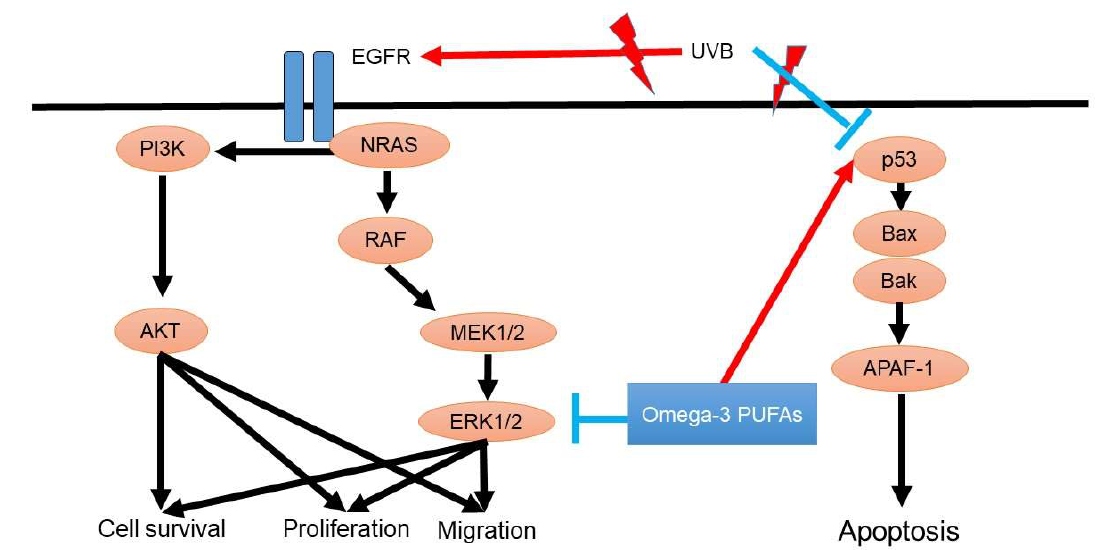
Figure 3. Oncogenesis signaling of squamous cell carcinoma and possible roles of omega-3 PUFAs. P53 gene mutation is a crucial step in the development of cutaneous squamous cell carcinoma. P53 is responsible for cell apoptosis, DNA repair, and cell cycle arrest in squamous cell carcinoma. In addition, EGFR-mediated PI3K/AKT signaling and NRAS/RAF/MEK/ERK signaling also contribute to the development of squamous cell carcinoma.